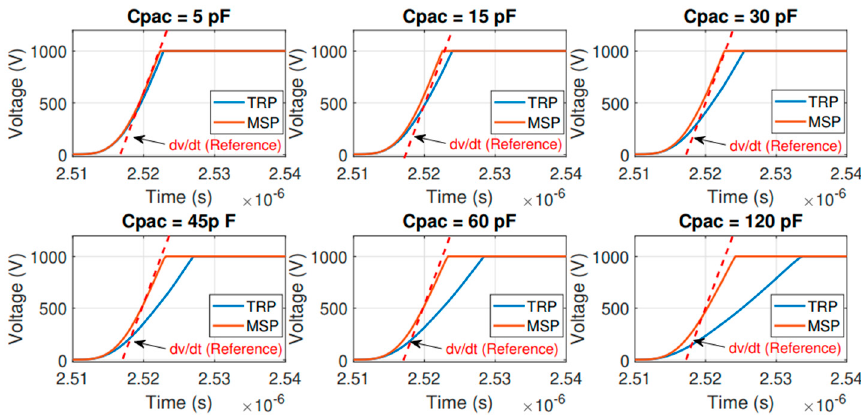
Figure 11. dv/dt as a function of Cpac for TRP and MSPs/layouts. Figure 11. dv / dt as a function of Cpac for TRP and MSPs /